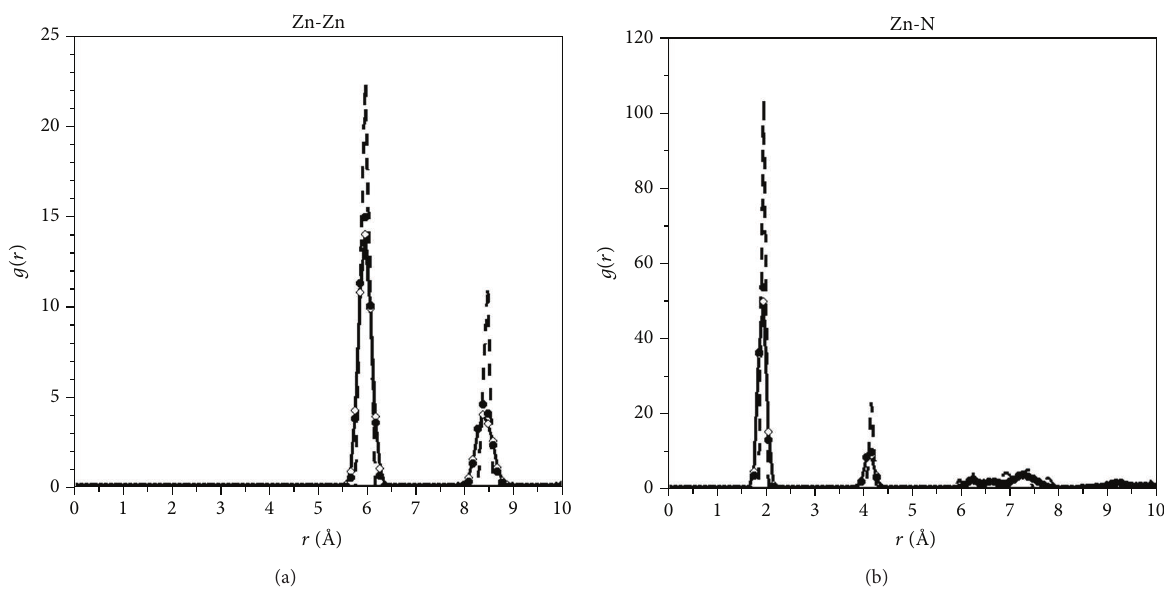
Figure 8: The Zn-Zn and Zn-N RDFs of ZIF-11 frameworks obtained from SIM I (--), SIM III (- ∙ -), and SIM IV (- ◊ -),